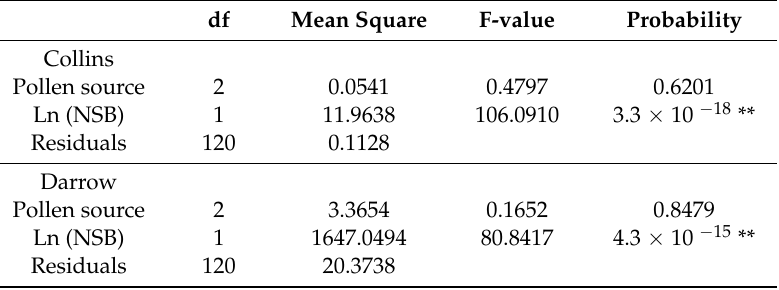
Table 3. Results of ANCOVA with NSB as a covariate determining the differences in adjusted BW among the pollination by different sources of pollen (2013 experiment). df Mean Square F-value